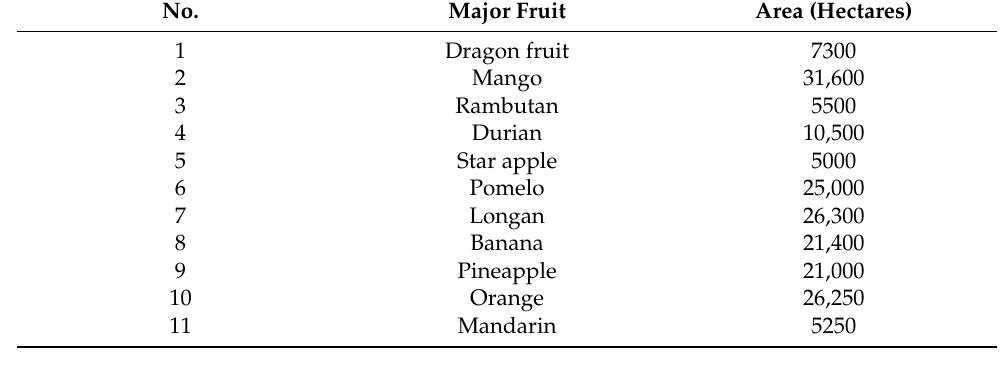
Table 5. Major fruit in Mekong Delta, Vietnam